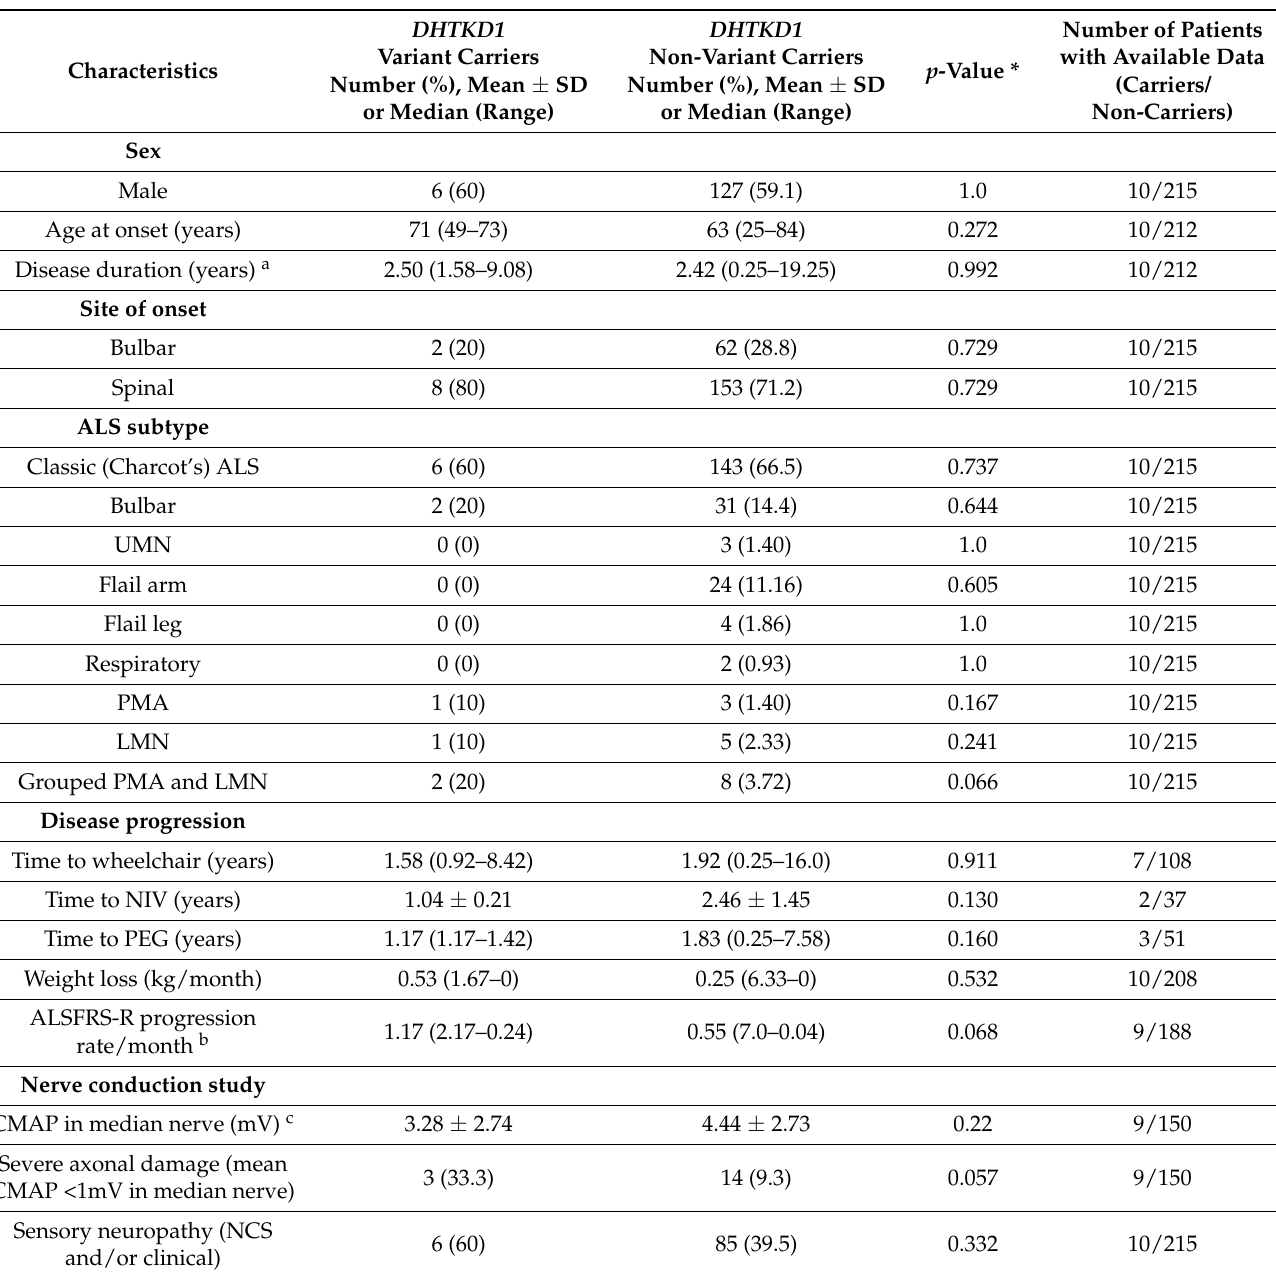
Table 4. Clinical and electrophysiological characteristics of ALS patients from cohort 1 comparing DHTKD1 variant carriers and